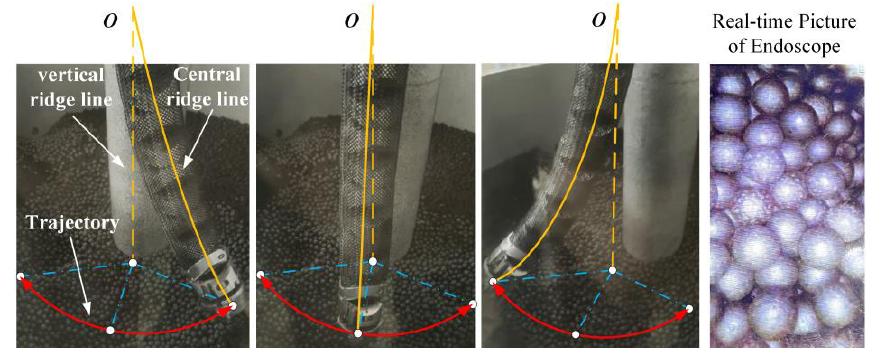
Figure 13. Sector-scanning motion of the suction ball.